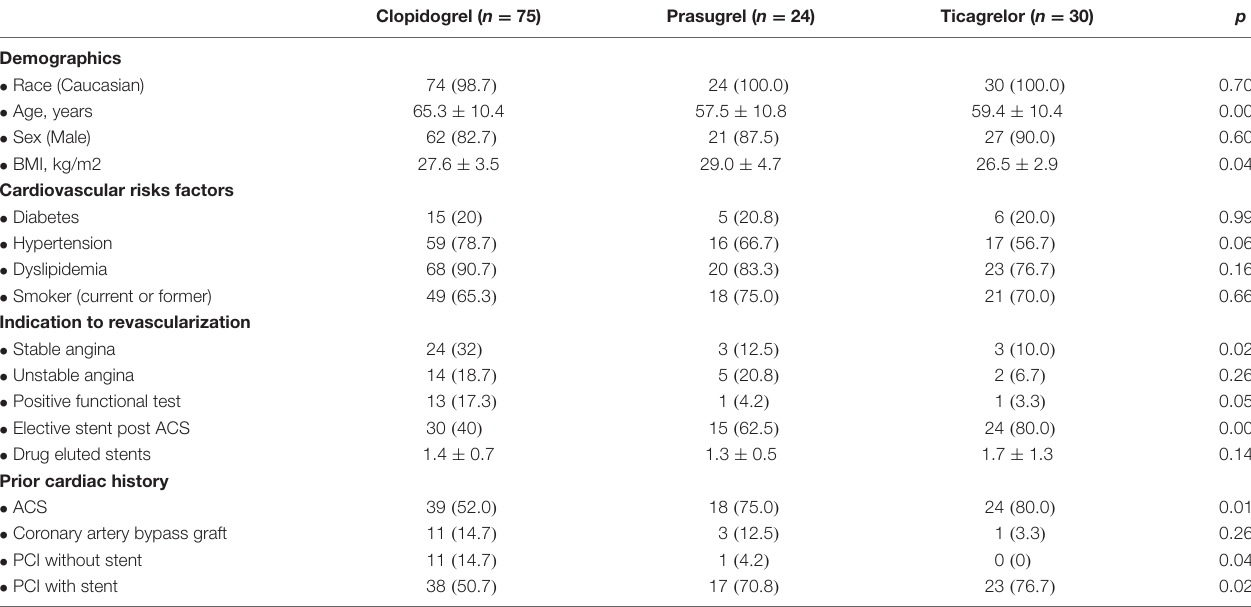
TABLE 1 | Demographic, clinical and procedural characteristics of the study patients according to the anti-P2Y12 drug at inclusion.